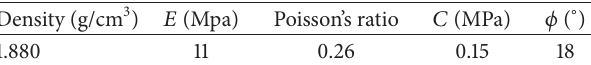
Figure 5: The 𝑒 - 𝑝 curve of soil. Table 3: Constitutive parameters.